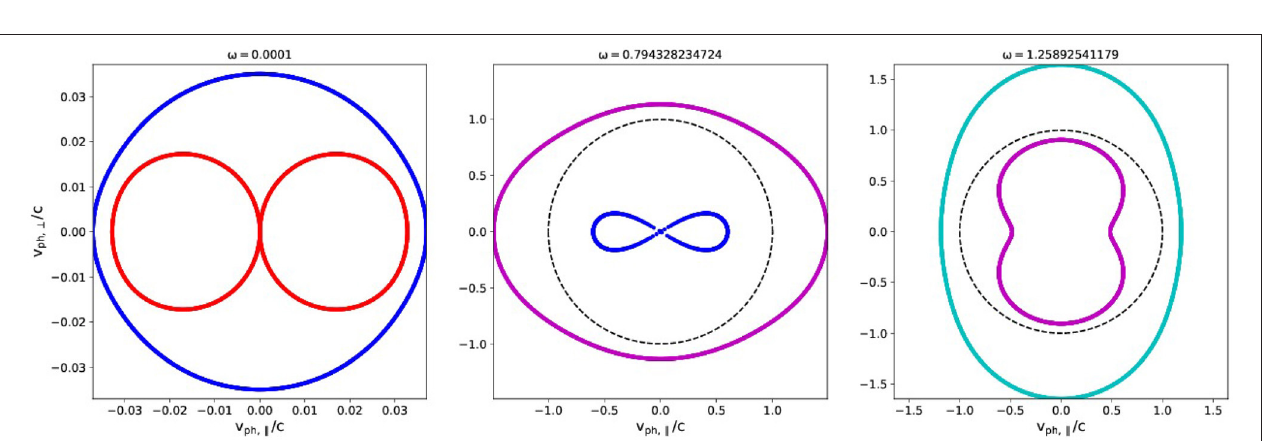
FIGURE 8 | Wave normal surfaces at fixed frequencies for the hydrogen ion-electron plasma at E